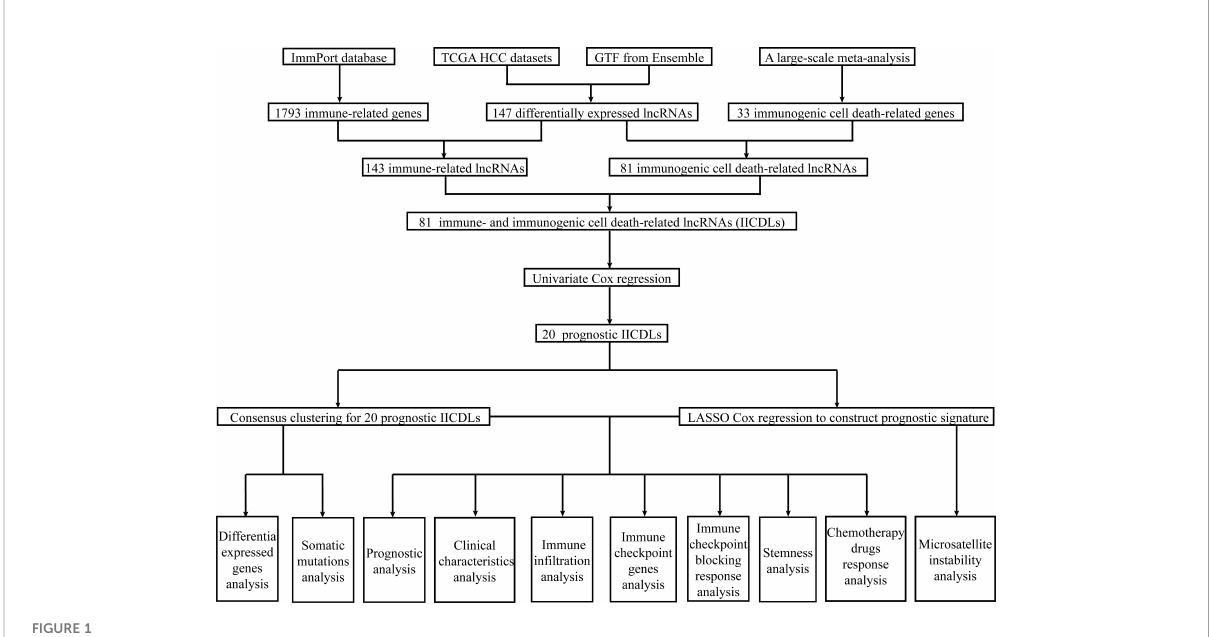
FIGURE 1 Work fl ow of the